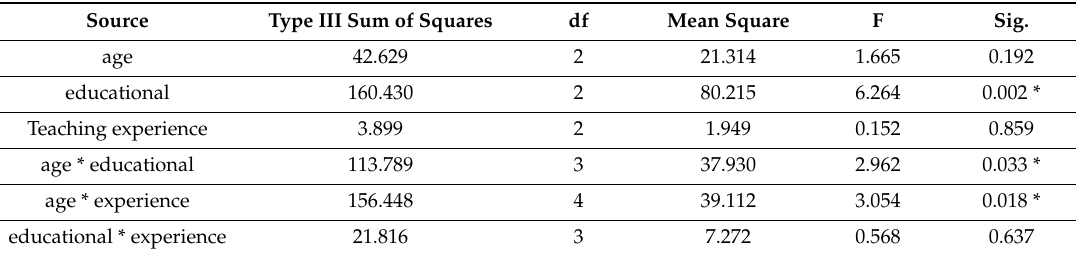
Table 11. Two-way ANOVA for personal